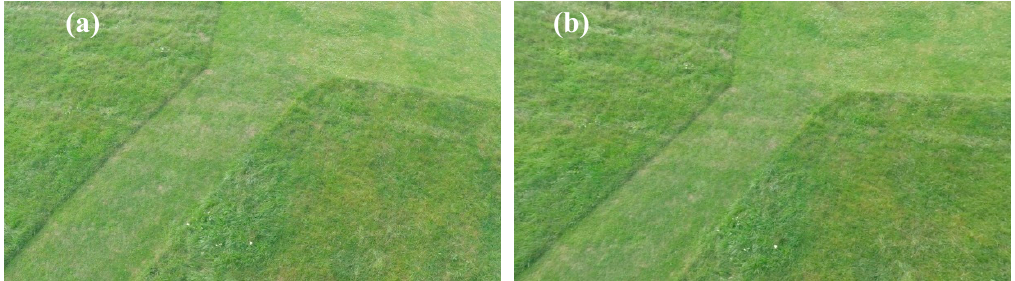
Figure 8. ( a ) The original image with distortion; ( b ) Undistorted image.